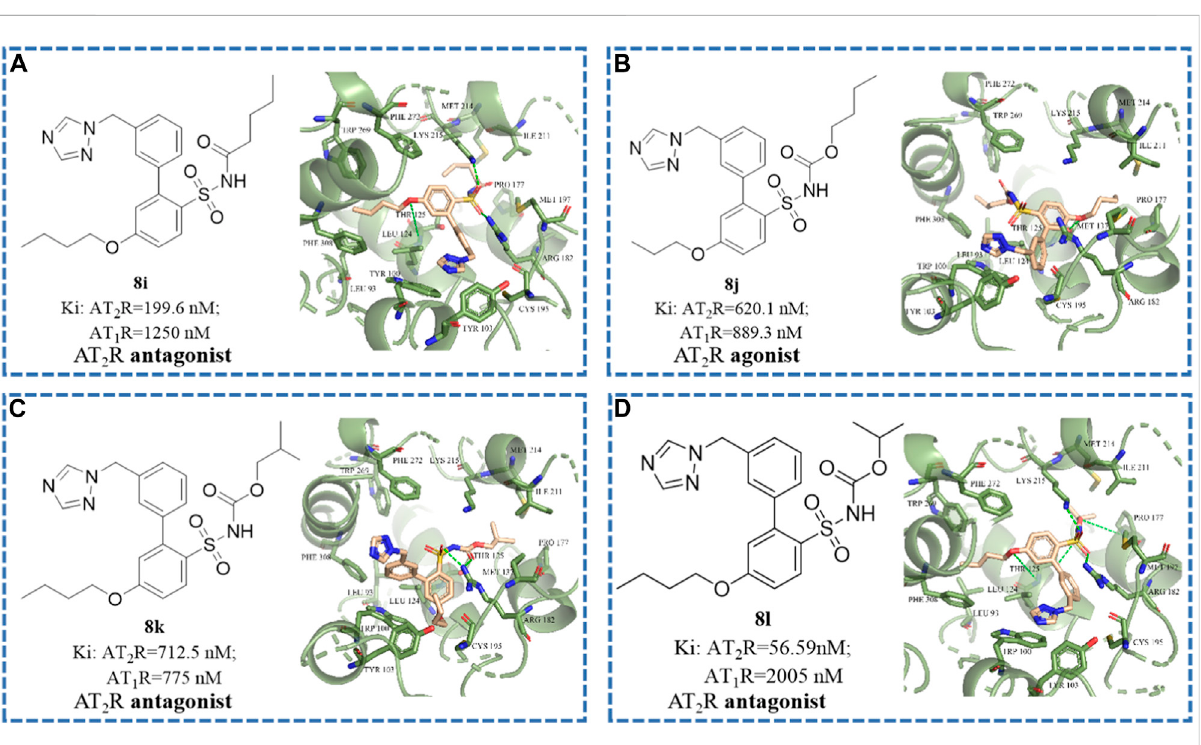
FIGURE 4 The structural formula and docking results of compounds (A) 8i , (B) 8j , (C) 8k , and (D) 8l . The green dotted line indicates hydrogen bond